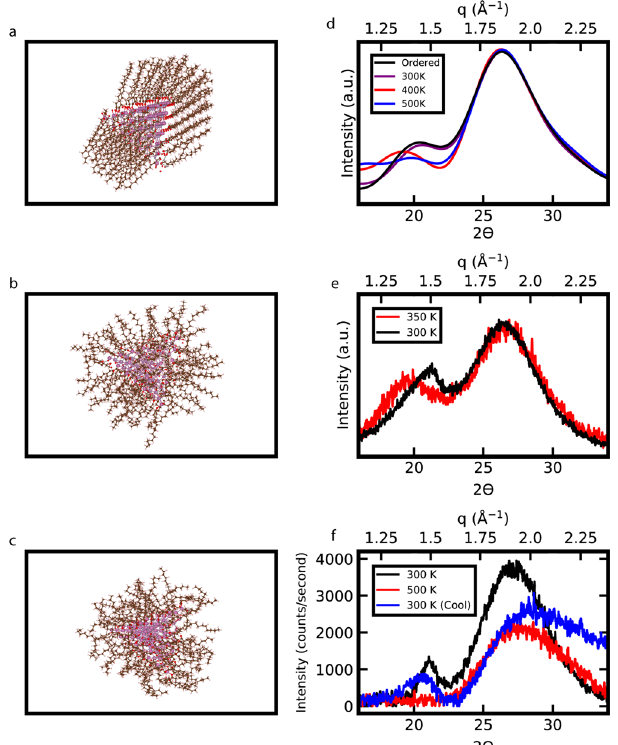
Fig. 4 Atomic models and simulated powder X-ray diffraction spectra of indium phosphide quantum dots with ligand ordering simulated through molecular dynamics compared with experimental data. a Atomic model of an indium phosphide quantum dot capped with myristates after molecular dynamics simulations at 300 K. b Atomic model of an indium phosphide quantum dot capped with myristates after molecular dynamics simulations at 400K. c Atomic model of an indium phosphide quantum dot capped with myristates after molecular dynamics simulations at 500 K. d Simulated powder X-ray diffraction spectra of indium phosphide quantum dots before and after molecular dynamics simulations. e Experimental powder X-ray diffraction spectra of indium phosphide quantum dots capped with stearate depicting the peak shifting and decreasing in intensity at an increased temperature. f Experimental powder X-ray diffraction spectra of indium phosphide quantum dots capped with stearate showing the disappearance of the ligand peak at 500 K followed by its reappearance when cooled back to 300 K. Note that patterns depicted in e and f were measured on different instruments. The broadening of the (111) diffraction peak in the heated and cooled spectra is evidence that the sample may have slightly degraded due to sustained high temperatures. Cu K- α ð λ ¼ 1 : 5418 Å Þ is the X-ray source for all experimental and simulated powder X-ray diffraction solvent still immediately before being stored in an argon glovebox. Tris(tri- methylsilyl)phosphine (98%, Strem Chemicals) and acetone (99.8%, Acros Organics) were also stored in an argon glovebox. Palmitic acid (99%), oleic acid (90%), 1-octadecene (90%), oleylamine (70%), and hydro fl uoric acid (99.99%, 48 wt% in H 2 O) were purchased from Sigma-Aldrich and used as received. Stearic acid (98%, Alfa Aesar), octadecylphosphonic acid (>99%, PCI Synthesis), dimethyl sulfoxide (99.9% Fisher Scienti fi c), argon (99.999%, Airgas), and hydrogen (5% in argon, Airgas) were used as received. Indium phosphide quantum dot synthesis . This synthesis and characterization of the indium phosphide quantum dots for comparison of carboxylate lengths has previously been reported 7,8 . For the synthesis, 0.350 g (1.20 mmol) of indium acetate with 3.60 mmol of the targeted carboxylic acid (0.822 g of myristic acid, 0.923 g of palmitic acid, 1.024g of stearic acid, and 1.017g of oleic acid) were combined with 10 mL of 1-octadecene in an oven-dried, 50mL three neck round- bottom fl ask with a Te fl on coated stir bar. After an air condenser column, septa, and thermocouple adapter were attached to the fl ask and all glass joints were greased with Apiezon H grease, the fl ask was heated using a heating mantle and